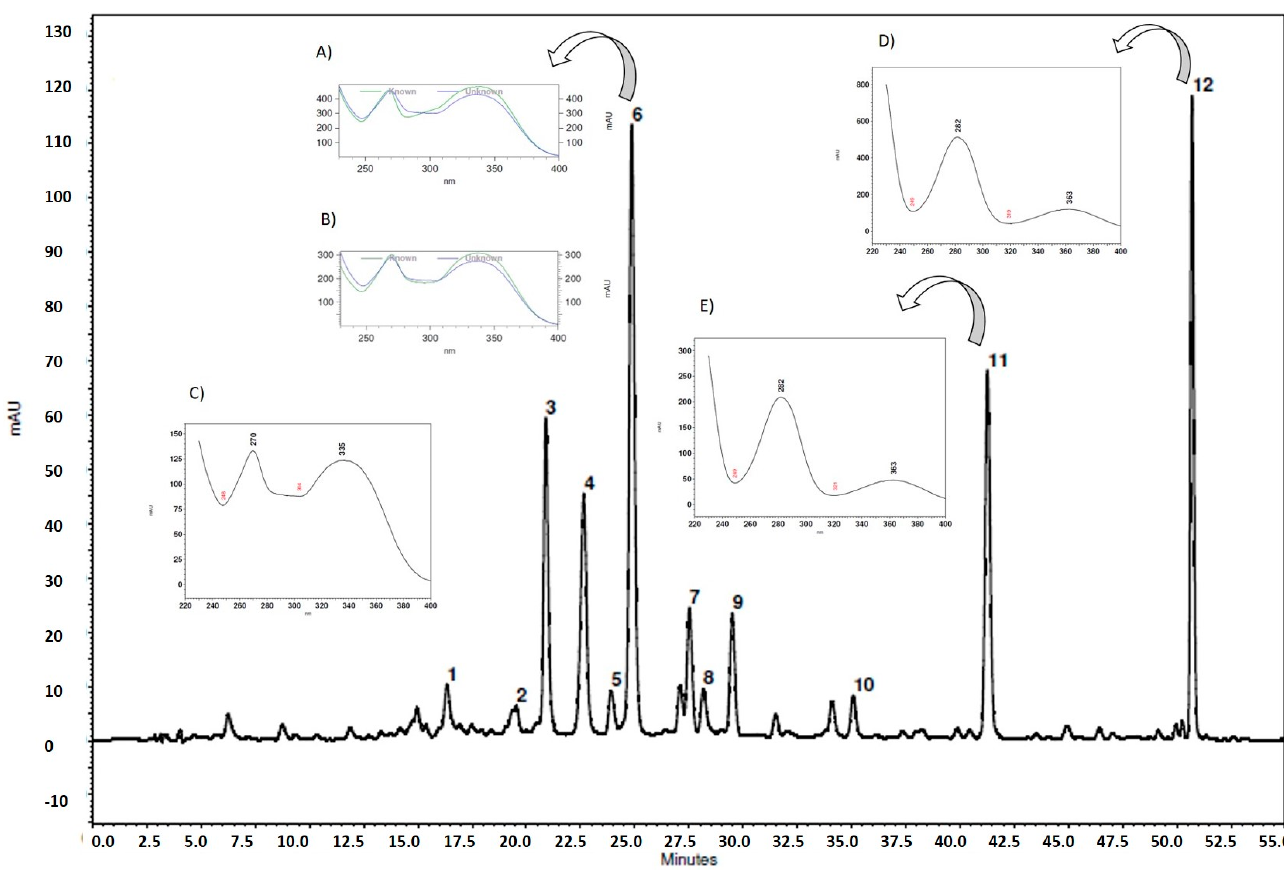
Figure 2. Chromatographic profile of aqueous extract M. chamissois Naudin leaves (B4) by HPLC/DAD at 354 nm. Detection at 354 nm, C18 column, flow rate of 0.6 mL/min, eluent: phos- phoric acid 1%, and acetonitrile in gradient system. ( a ) similarity of peak 6 (t R 24.89 min, λ max: 270, 336) and vitexin standard compound (similarity index: 0.9959); ( b ) similarity of peak 6 (t R 24.89 min) and isovitexin standard compound (similarity index: 0.9951), ( c ) peak 6 (t R 24.89 min, λ max: 270, 336); strongly suggestive a vitexin or isovitexin related compound ( d ) peak 11 (t R 41.27 min; λ max: 282, 363) miconioside B; ( e ) peak 12 (t R 50.76 min; λ max: 282, 363) matteucinol-7- O - β -apiofuranosyl (1 → 6)- β -glucopyranoside.